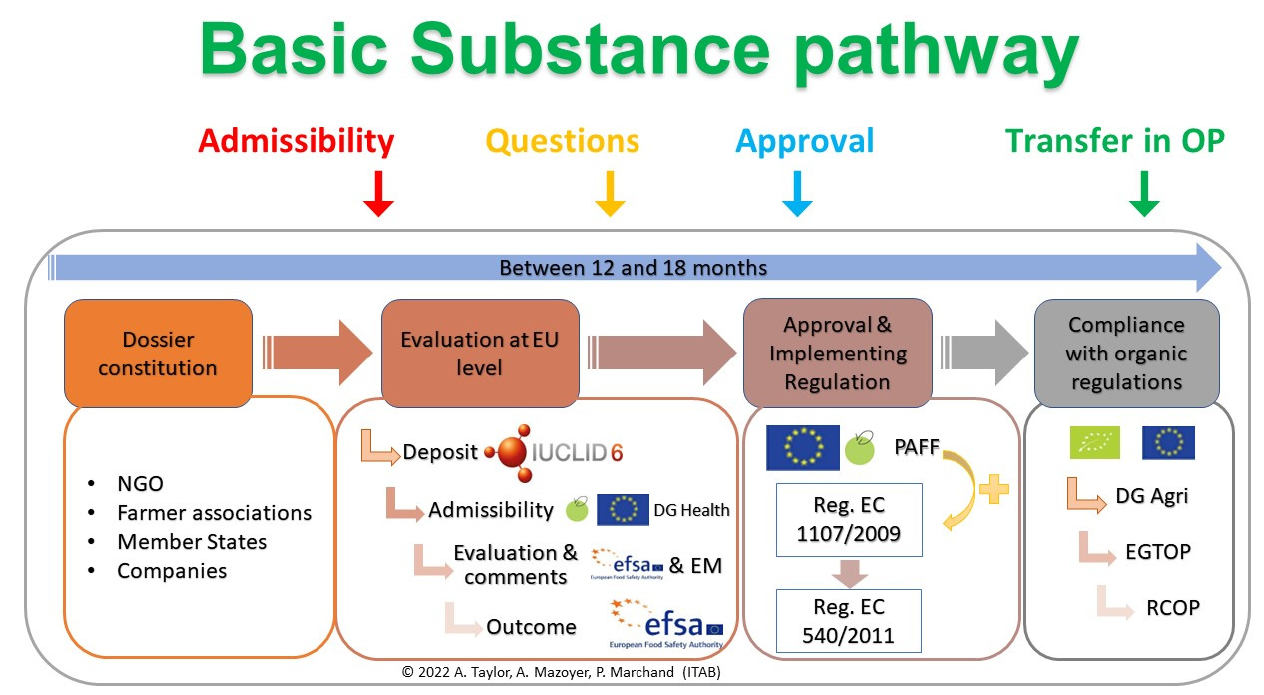
Figure 3. Approval process and timeline of a Basic Substance Application